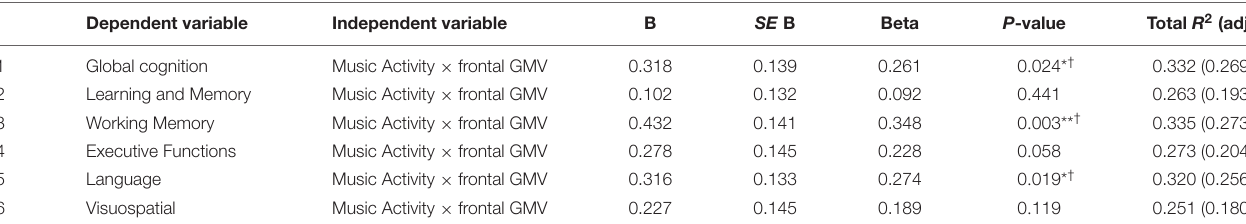
TABLE 4 | Results of the moderation analyses between musical activity and frontal